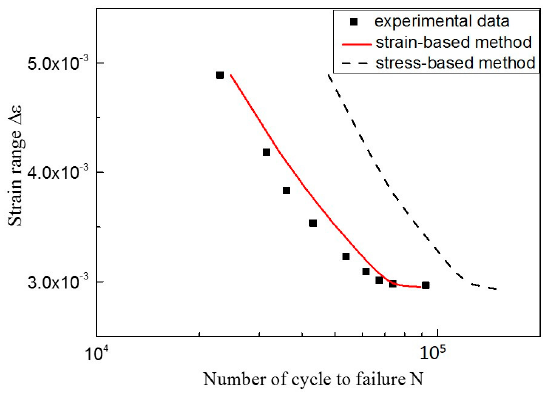
Figure 14. Predicted fatigue life of AZ31 magnesium alloy.